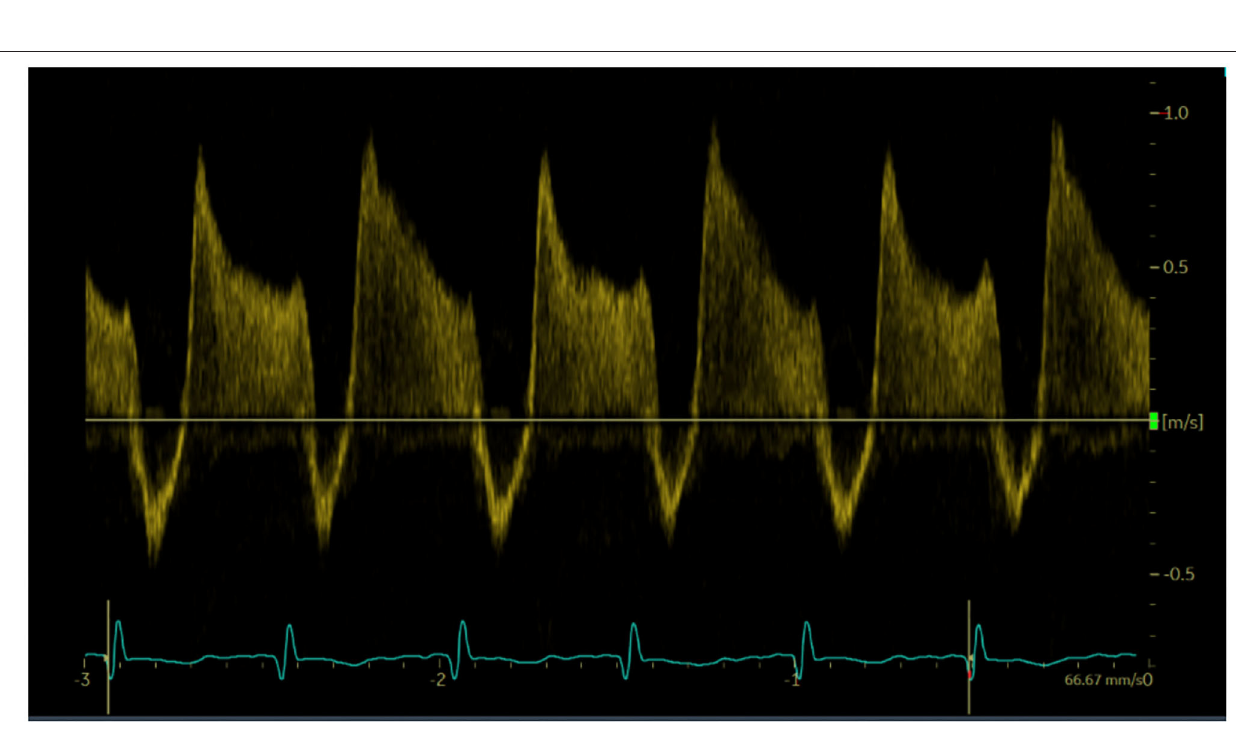
Frontiers in Pediatrics |